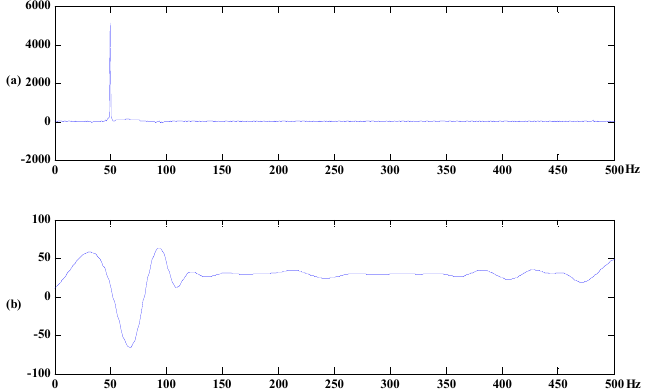
Figure 10. Empirical mode decomposition and reconstruction results of the simulated signal. ( a ) The 50 Hz interference spectrum curve decomposed and reconstructed by the empirical mode decomposi- tion (EMD) method; ( b ) The decomposed and reconstructed random signal spectrum